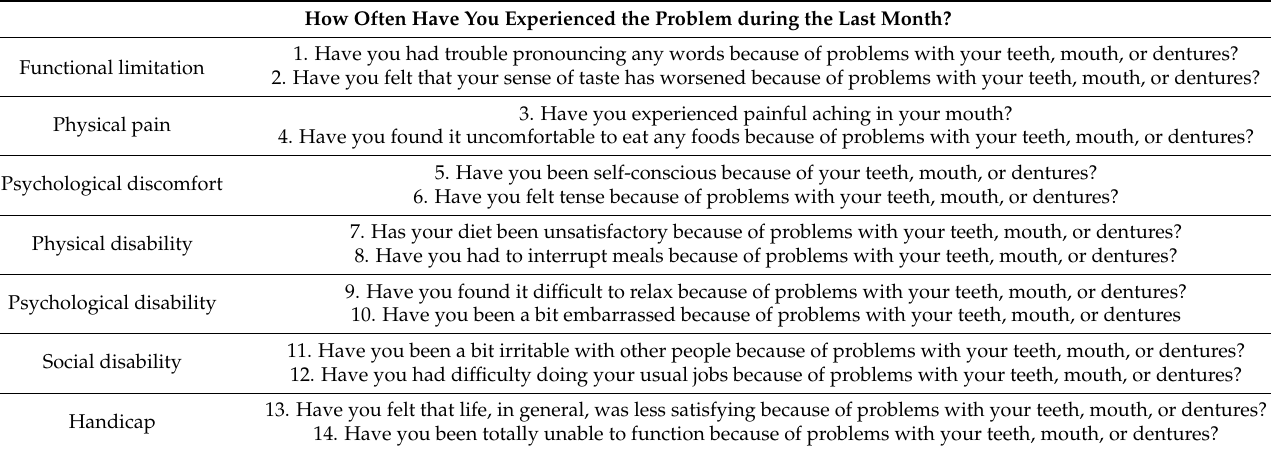
Table 2. Short-form oral health impact profile